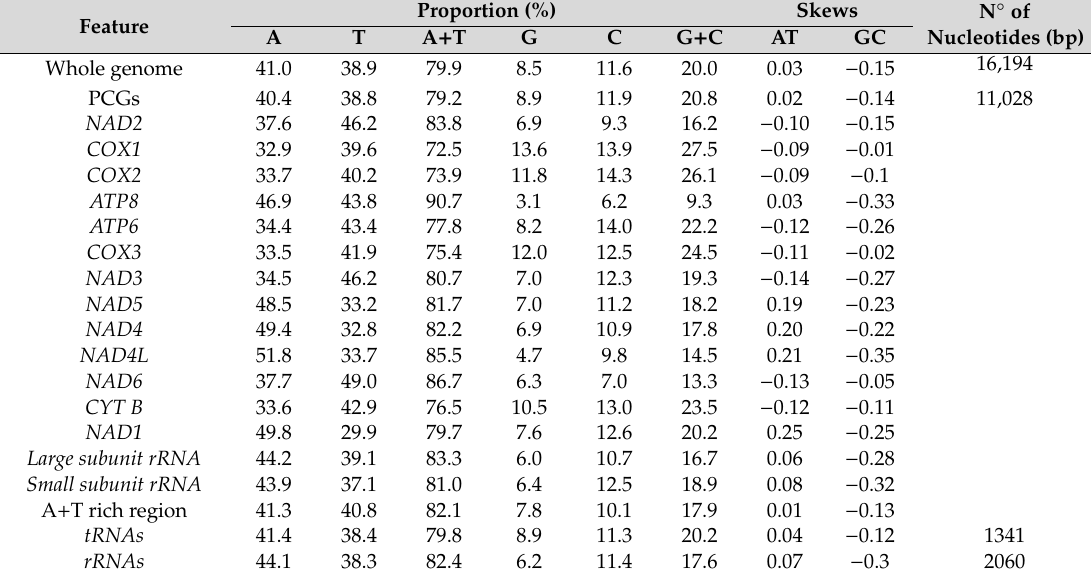
Table 3. Nucleotide composition of the Eriopis patagonia mitogenome. Protein-coding genes (PCGs), transfer RNAs (tRNAs), and ribosomal RNAs